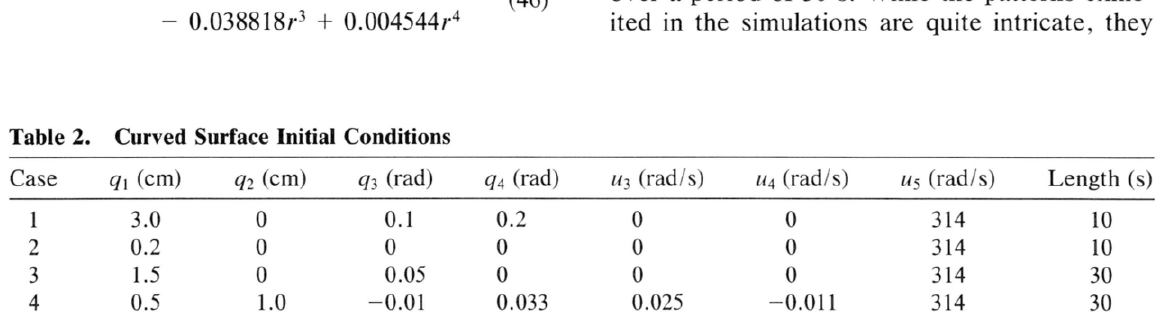
Table 2. Curved Surface Initial Conditions